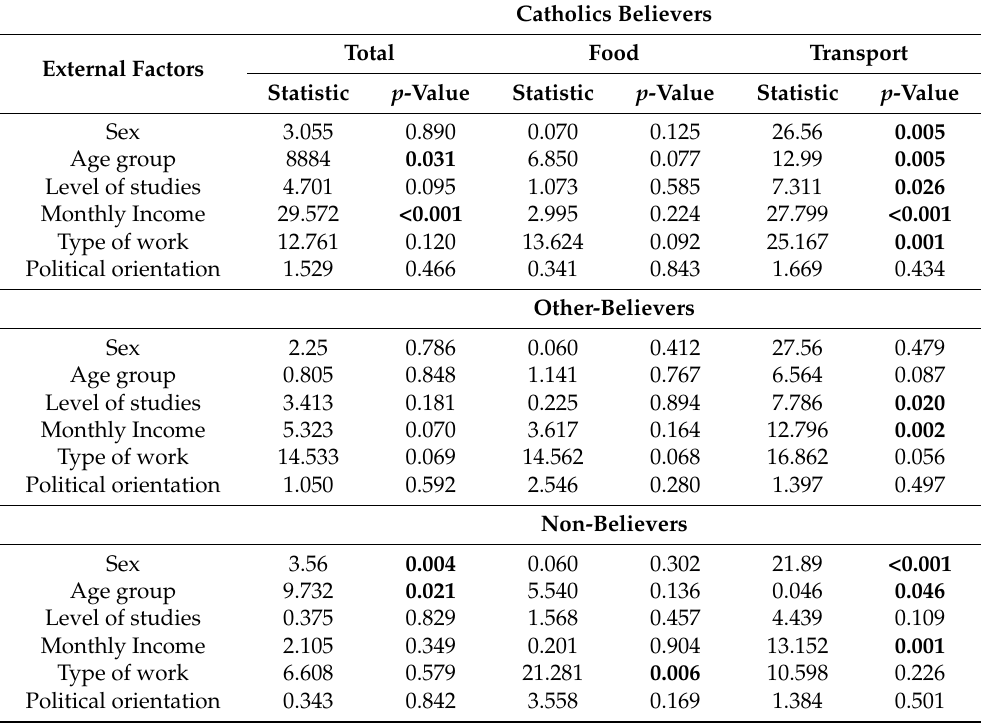
Table 4. Differences in personal CF across external factors for each religious group.